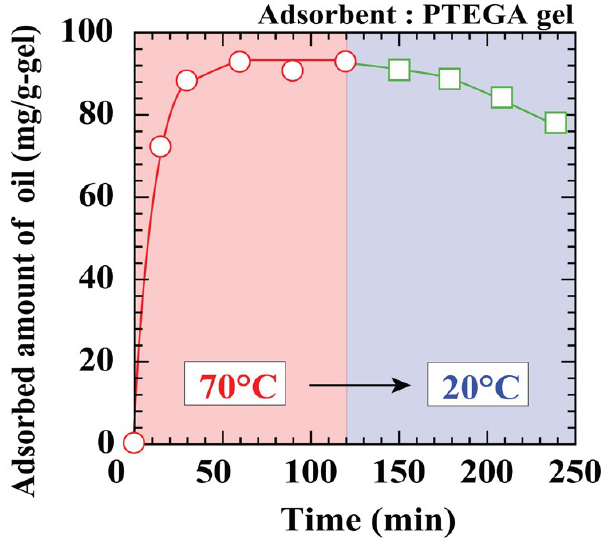
Figure 7. Regeneration of PTEGA gel without Figure 7 . Regeneration of PTEGA gel without surfactant. Figure 7 . Regeneration of PTEGA gel without surfactant.